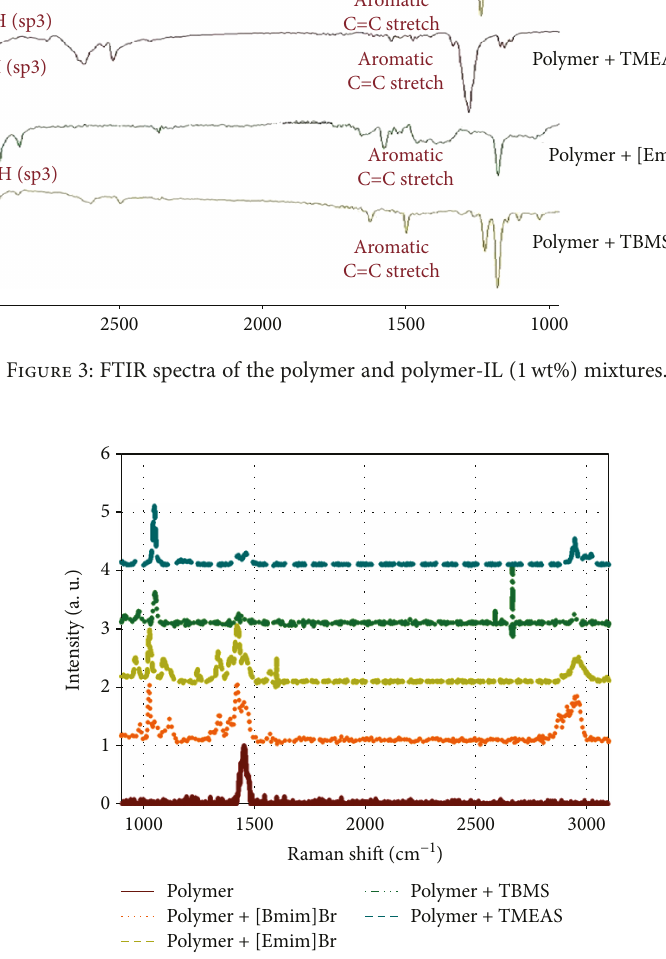
Figure 4: Confocal Raman spectroscopy data of polymer and polymer-IL (1 wt%) mixtures. Table 1: Conductivity of polymer and polymer-IL mixture (I